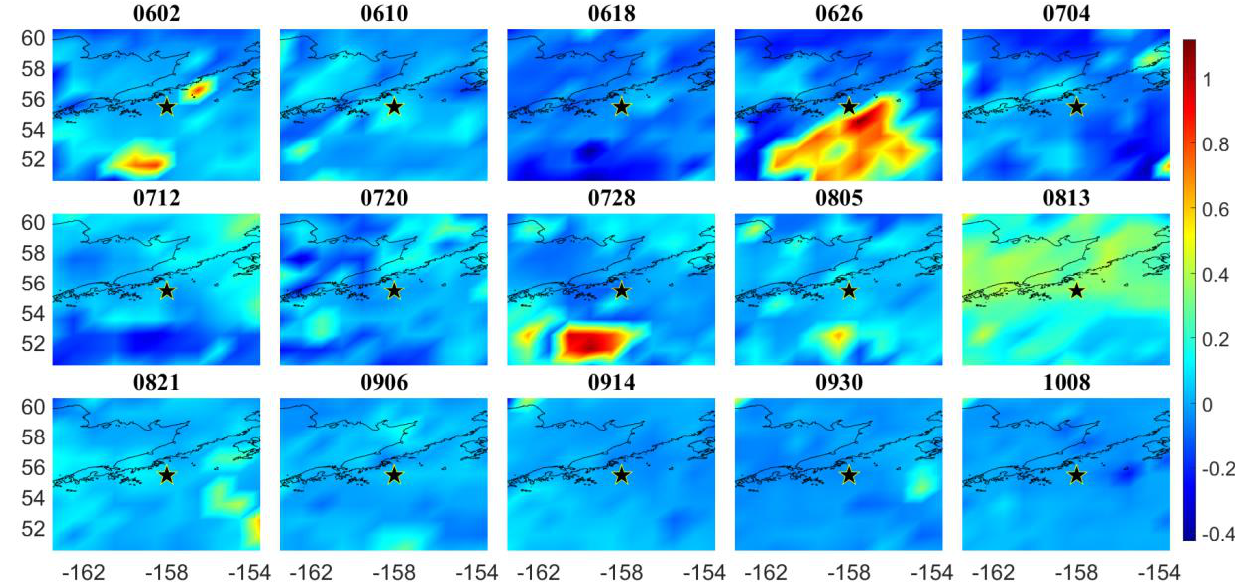
Figure 8. The variation in 8 days averaged AOD during the EQ time after removal of the background, which is built by AOD values from 2001–2021 over the Alaska epicenters. The star denotes the epicenter